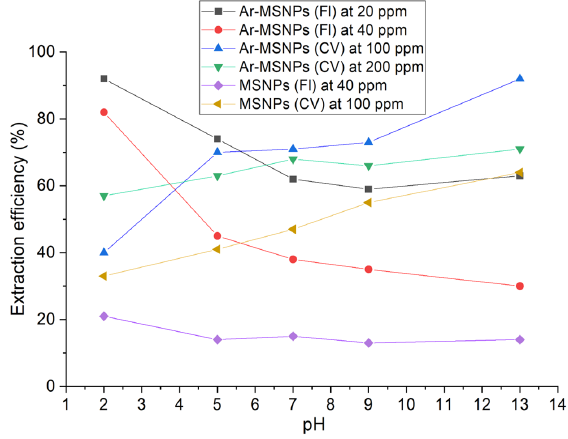
Figure 6. Effect of initial pH on CV adsorption onto the Ar ‐ MSNPs surface at a temperature of 23 °C, the adsorbent dosage of 10 mg, and a shaking speed of 200 rpm for 24 h.